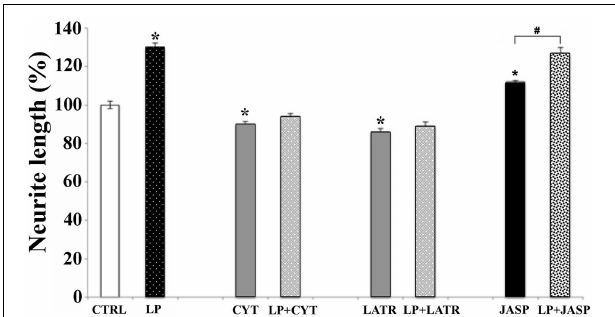
FIGURE 5 | Actin polymerization is required for neurite elongation induced by 5-HT7R stimulation. Striatal primary cultures were treated for 2h with the 5-HT7R selective agonist LP-211 (LP, 100nM). Cells were also treated with compounds depolymerizing actin filaments, as cytochalasin B (CYT, 100nM) or latrunculin A (LATR, 2 µ M), or promoting actin polymerization as jasplakinolide (JASP, 2 µ M), with or without LP. The graph shows the neurite length expressed as percent values in reference to vehicle-treated cultures (CTRL, set to 100%). The bars represent means ± SEM from randomly selected fields for each cell culture condition ( n = 9 ). Asterisk (*): values significantly different from CTRL by One Way ANOVA followed by Dunnett post-hoc test ( p < 0 . 05 ). Number sign (#): values significantly different from each other by One Way ANOVA followed by Tuckey post-hoc test ( p < 0 . 05